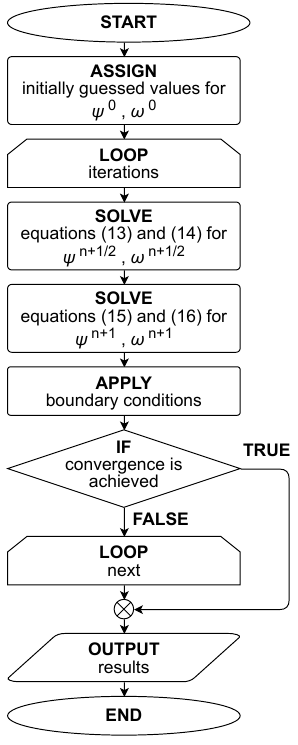
Figure 2. The numerical